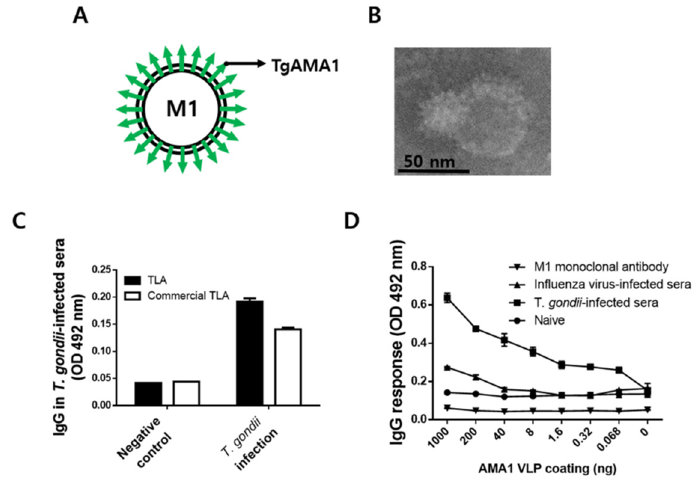
Figure 1. Production of AMA1 VLPs and TLA. Schematic illustration ( A ) and TEM ( B ) for T. gondii AMA1 VLPs. AMA1 antigens were expressed on the surface of VLPs, in which influenza M1 was used as a core protein. The TLA we generated was compared with commercial TLA by ELISA using T. gondii -infected mouse sera ( C ). The T. gondii -specificity of the AMA1 VLPs were evaluated by comparing their antibody response induction against influenza infection-positive sera, naïve sera, and M1 monoclonal antibodies ( D ). Datasets were presented as mean ± SD.